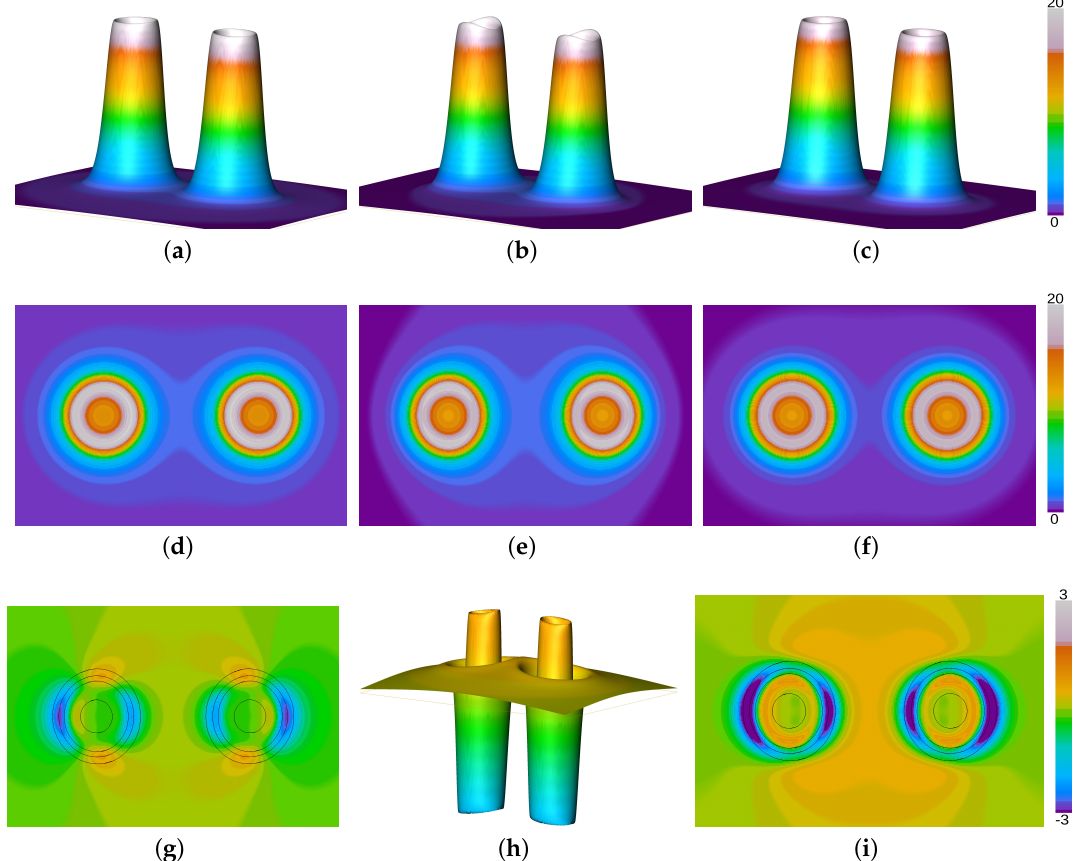
Figure 1. Pauli potentials for the N2 molecule from the atomic fragment approach using closed shell fragments (first column) together with the first order level (third column) and KS data (second column). ( a ) relative height field using closed-shell (cs) atomic fragments, ( b ) relative height field using molecular Kohn-Sham (KS) orbitals, ( c ) relative height field using groundstate (gs) atomic fragments, ( d ) orthoslice using cs atomic fragments, ( e ) orthoslice using molecular KS orbitals, ( f ) orthoslice using gs atomic fragments, ( g ) difference between the molecular and the cs Pauli potential (in black: isolines of the KS Pauli potential indicating regions of high contribution to the Pauli kinetic energy), ( h ) difference between the cs and the gs Pauli potential, ( i ) difference between the molecular and the gs Pauli potential (in black: isolines of the KS Pauli potential indicating regions of high contribution to the Pauli kinetic